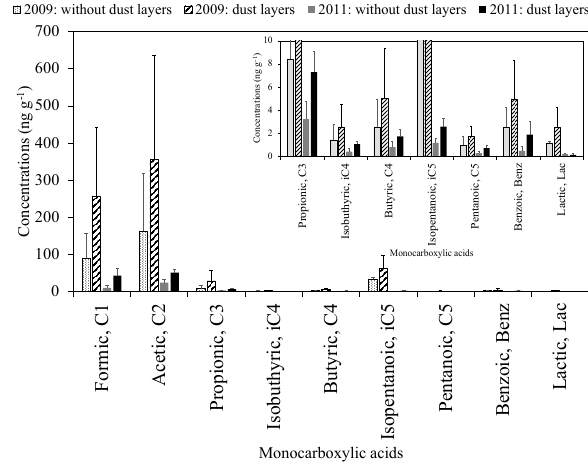
Figure 4. Concentrations of selected low molecular weight mono- carboxylic acids in Mt. Tateyama snow